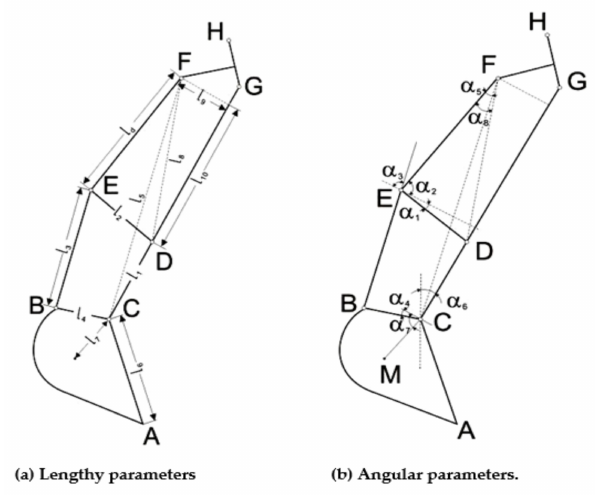
Figure 3. The geometric parameters of the bucket